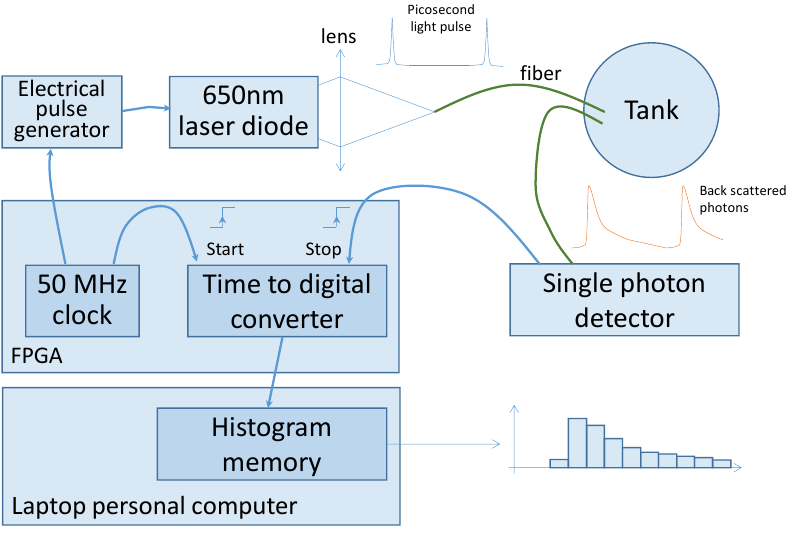
Figure 3. Schematic set-up of TROT.